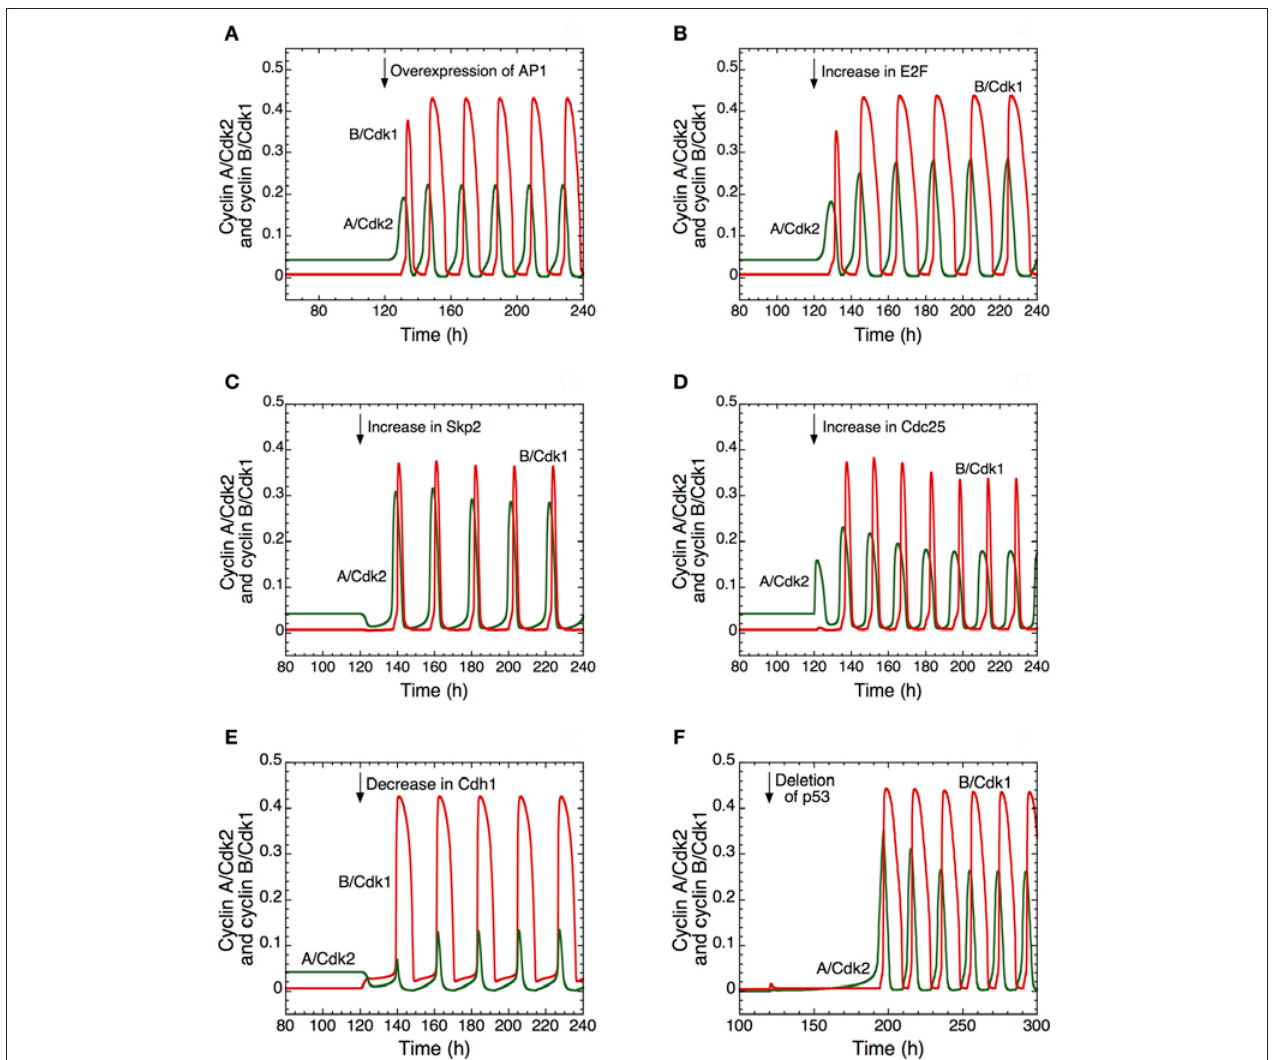
synthesis of the phosphatase Cdc25 acting on cyclin A/Cdk2, v spai , increases from 0.105 to 0.25 μ Mh − 1 in (D) ; the rate of synthesis of Cdh1, v scdh1a , decreases from 0.11 to 0.01 μ Mh − 1 in (E) ; the level of p53, considered as a parameter that enhances the synthesis of p21–p27, passes from 0.8 to 0 in (F) . For conditions (A) to (E) , the rate of synthesis of pRB, v spRB is equal to 1.1 μ Mh − 1 . For condition (F) , the rate of synthesis of p21–p27, v s1p27 [see Equation 24 in Gérard and Goldbeter (2009)] is multiplied by ( a + b · p 53 ) , where the first term of synthesis does not depend on p53 and the second is p53-dependent.; v s1p27 is equal to 4.8 μ Mh − 1 , a is equal to 0.2, while b is equal to 1. Other parameter values are as in Table S2 in Gérard and Goldbeter